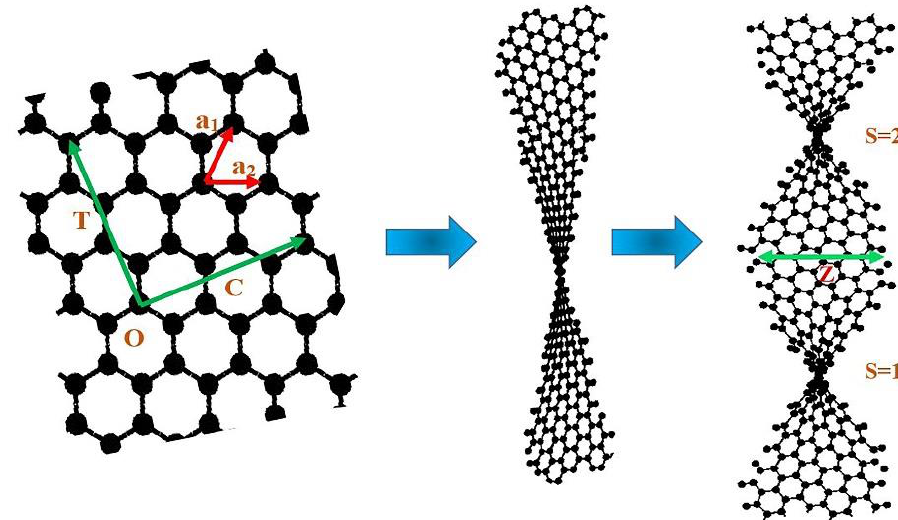
Figure 1. The twisted graphene that is achieved from a graphene sheet.